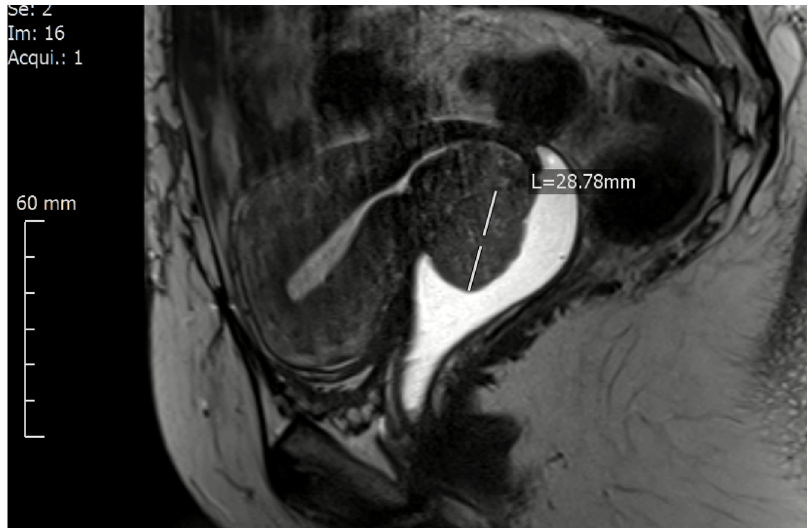
Figure 1. A magnetic resonance imaging of cervical cancer location on the ventral lip of the cervix (FIGO IB2) presented using a contrast agent in the vagina.